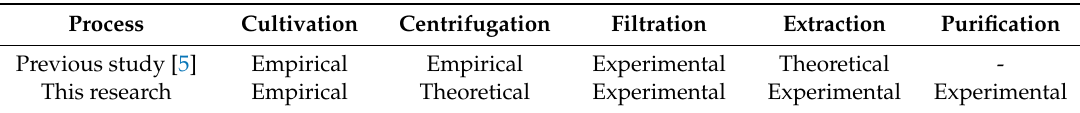
Table 3. Analytical process for each stage of microalgae production from the pilot plant located at Minamisoma.